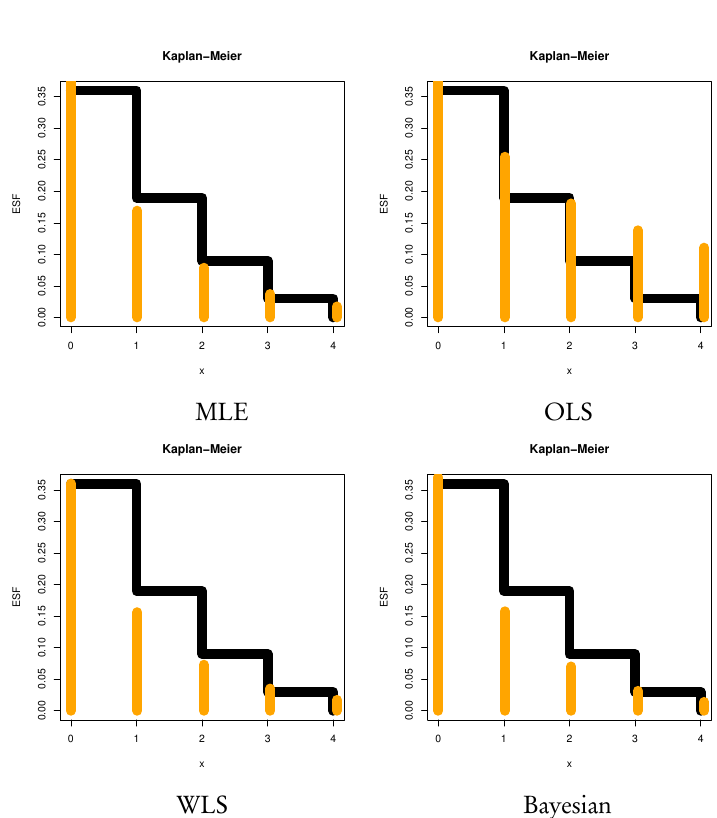
Figure 3 – Kaplan–Meier survival plots for the carious teeth